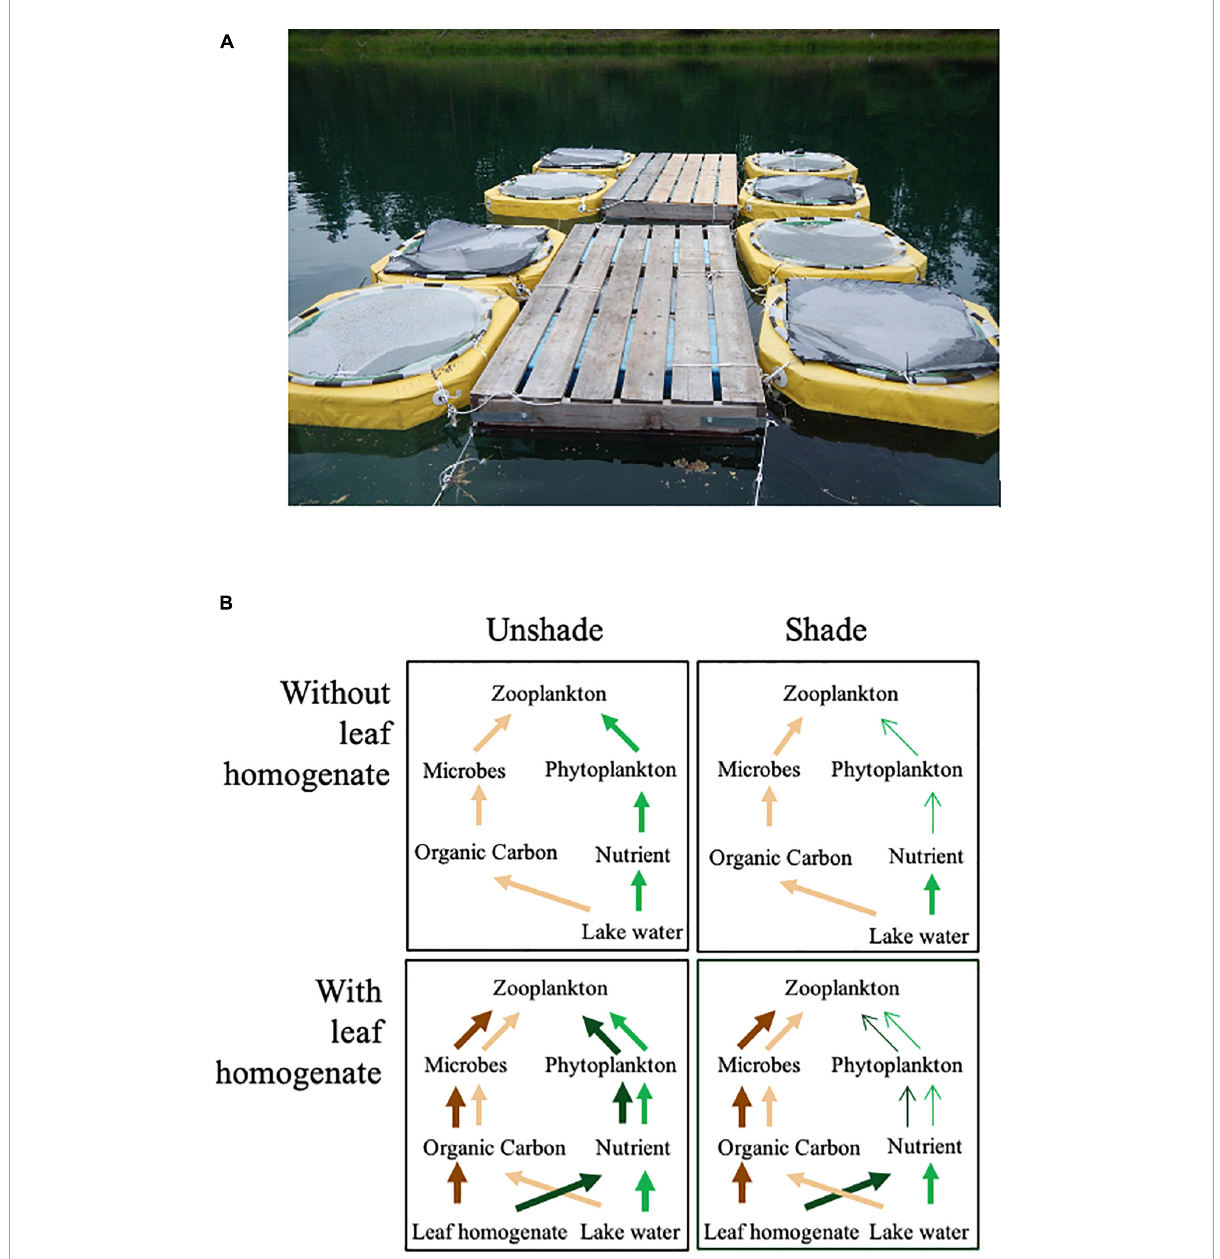
FIGURE1 (A) Photo showing enclosures used in the experiment. (B) Schemes showing the contribution of brown and green food chains for mass transfer to zooplankton under shaded and unshaded conditions with and without leaf homogenate. Light green arrows represent the effect of ambient nutrients on the green food chain (G Base ), light brown arrows represent the effect of ambient organic matter on the brown food chain (B Base ), dark green arrows represent the effect of leaf homogenate on the green food chain (G Add ), and dark brown arrows represent the effects of leaf homogenate on the brown food chain (B Add